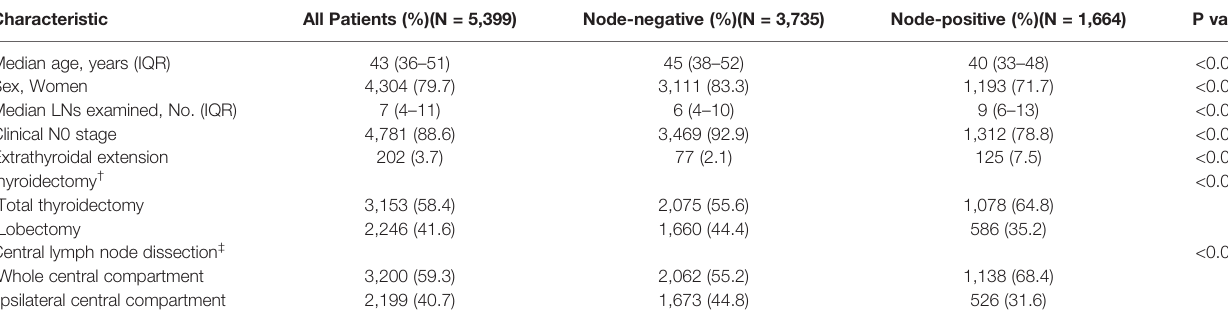
TABLE 1 | Characteristics of the patients used to generate the model according to the LN status.